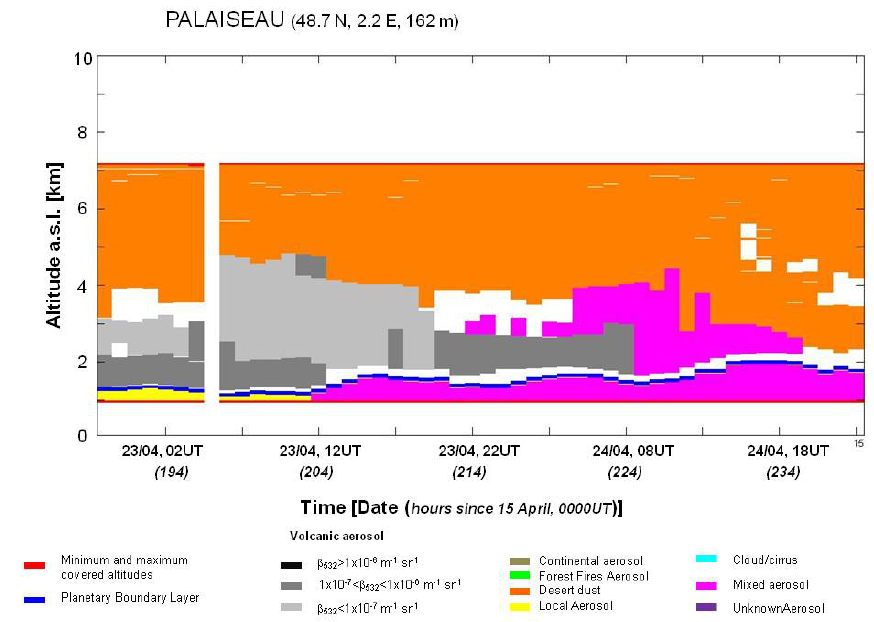
Fig. 2. Aerosol mask for the Palaiseau EARLINET site in the 23–24 April 2010